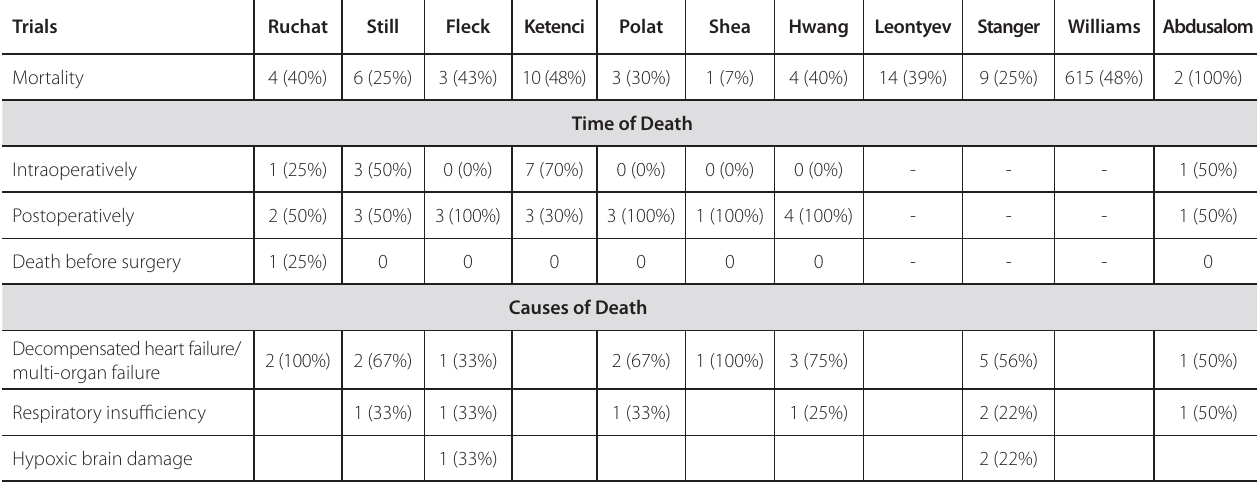
Table 3 . Time and causes of death of patients with iatrogenic acute aortic dissection occurring during cardiac surgery. Trials